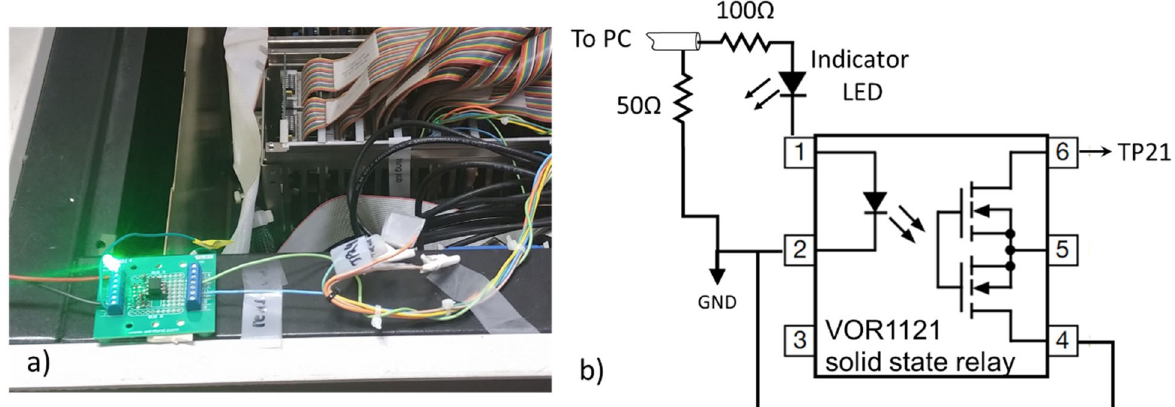
Figure 2. ( a ) Photo and ( b ) schematic of the interface circuit between the PC and the Clinac timing card. 5 V from the PC enables beam.